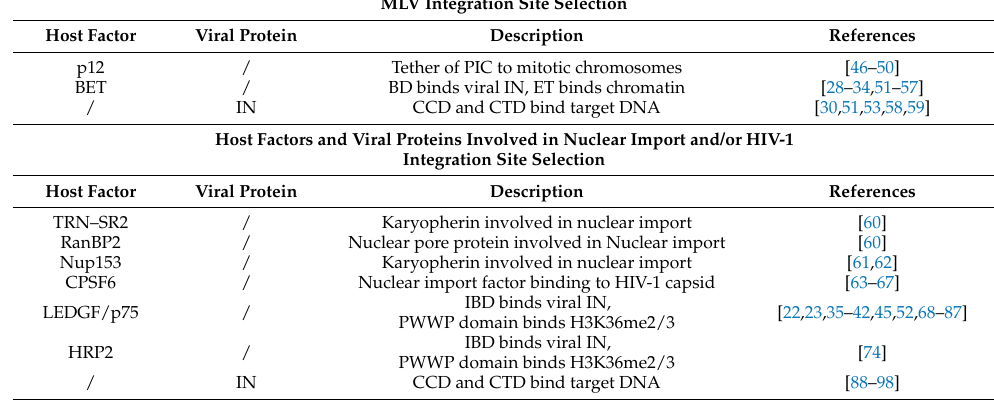
Table 1. Determinants of integration site selection of MLV and HIV-1. Bromodomain (BD); bromod- omain and extra terminal motif (BET); catalytical core domain (CCD); cleavage and polyadenylation specificity factor 6 (CPSF6); C-terminal domain (CTD); extra-terminal domain (ET); hepatoma- derived growth factor-related protein 2 (HRP2); integrase-binding domain (IBD); integrase (IN); lens epithelium-derived growth factor (LEDGF/p75); nucleoporin 153 (Nup153); pre-integration complex (PIC); ran–binding protein 2 (RanBP2); transportin SR2 (TRN-SR2). (Table created with Biorender.com on 17 December